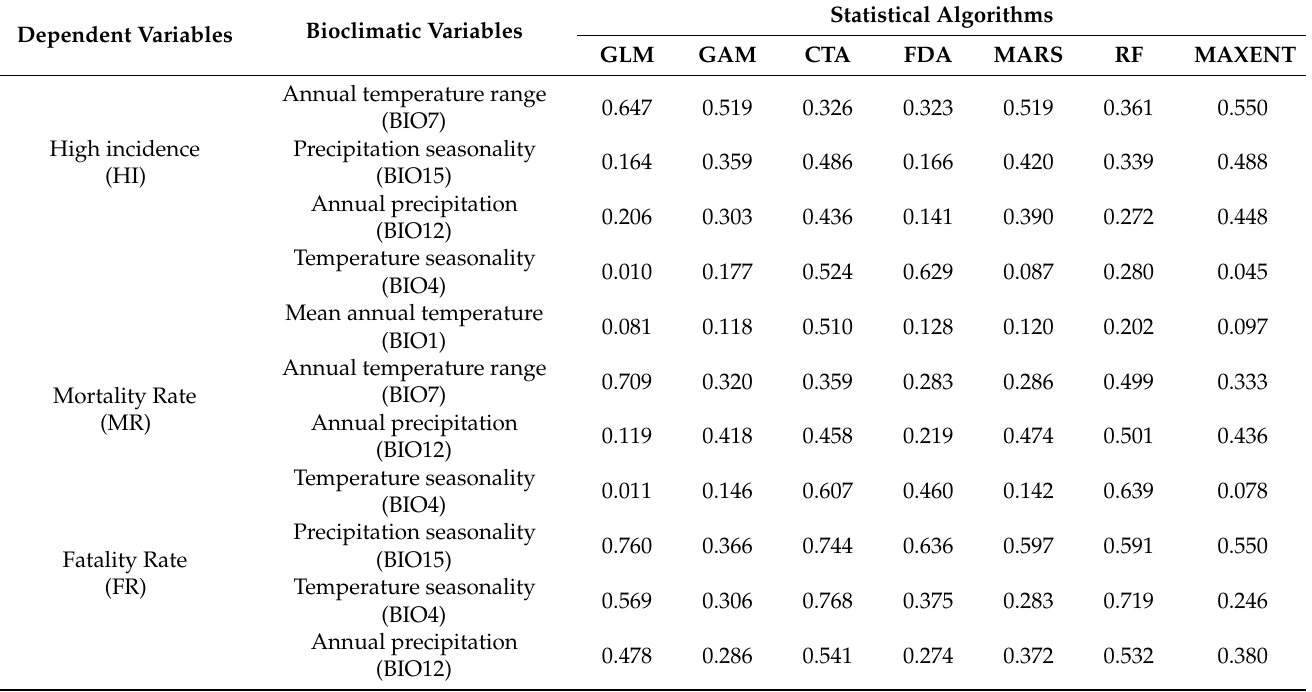
Table 1. Values of the relative contribution of bioclimatic variables to modeling HI, MR, and FR by COVID-19 in 2020 and 2021,